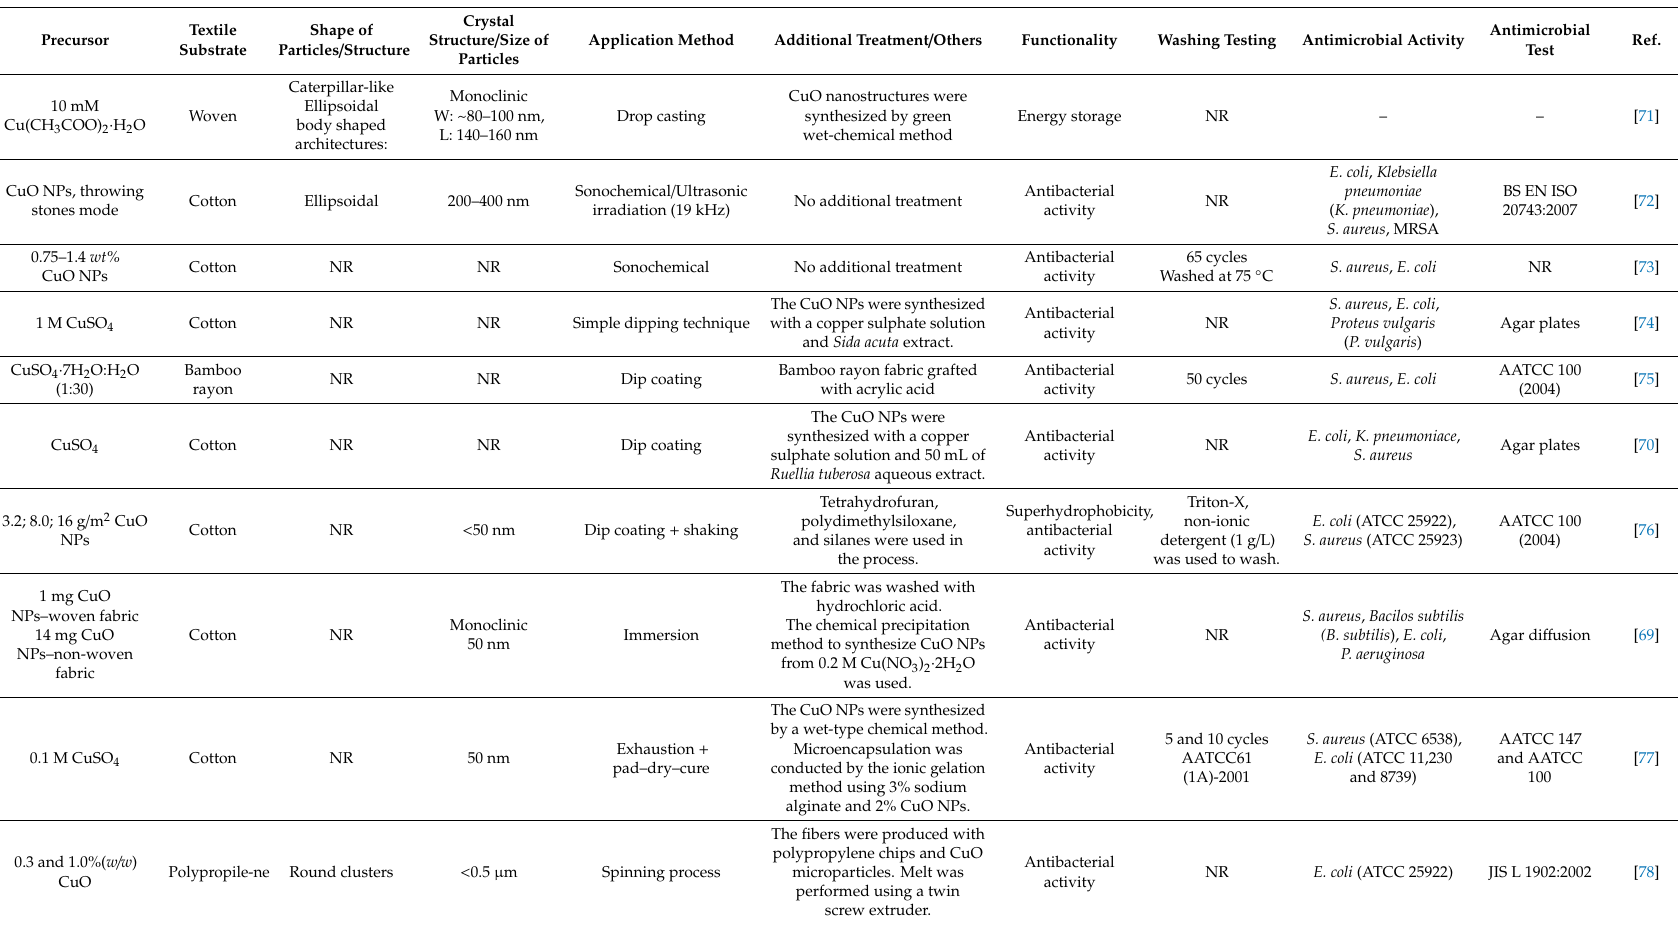
Table 2. Summary of the functionalization of textile materials with CuO NPs by the ex situ